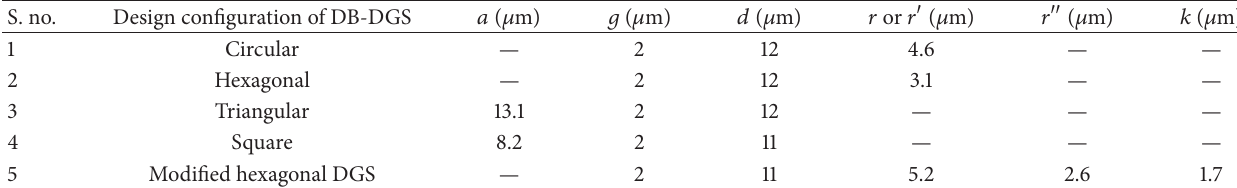
Table 1: Dimensions of various design configurations.